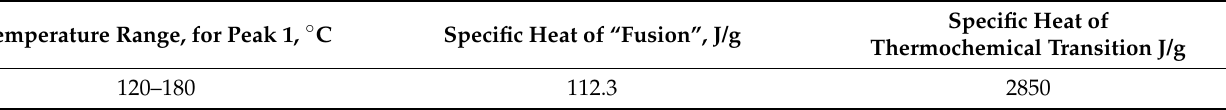
Table 1. Specific heat of the thermal effect at 163.7 ◦ C, estimated by two